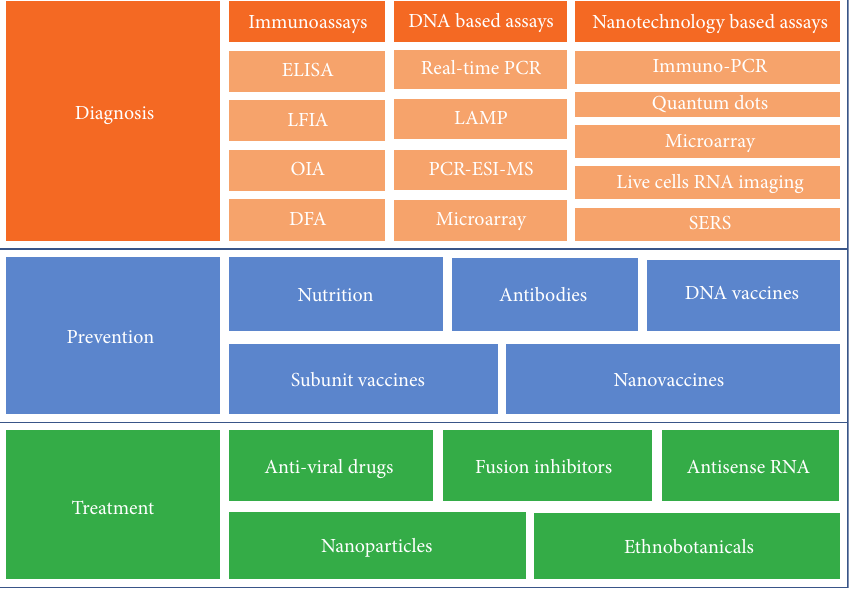
Figure 2: A schematic representation of RSV management through coordinated diagnosis, prevention, and